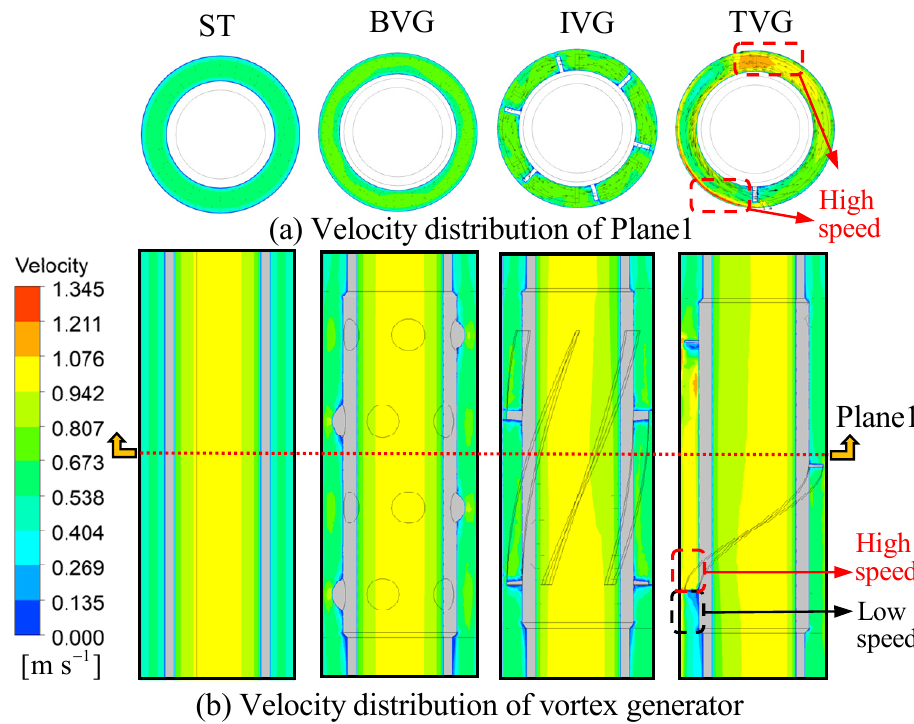
Figure 8. Velocity distributions in the vortex generator area of the four heat exchangers.